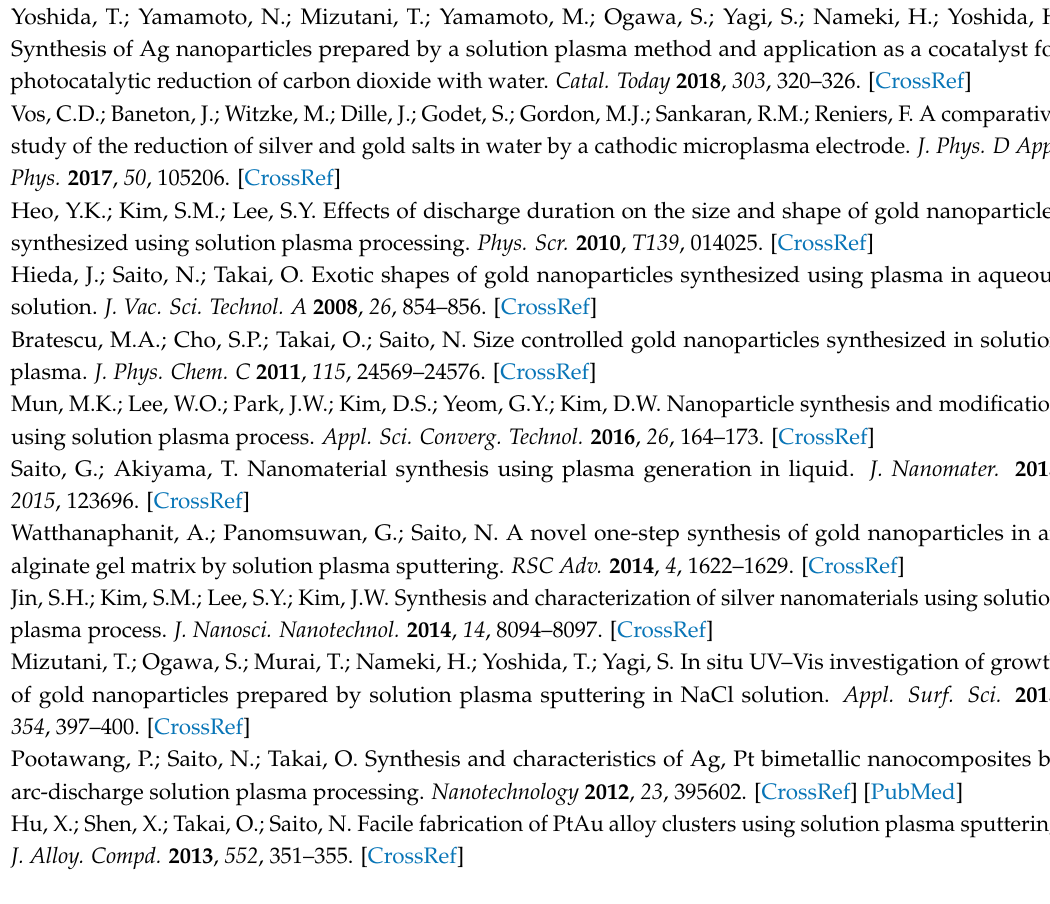
Figure S1: Solution color changes for three cases according to plasma process time, Figure S2: Change in length of powered and grounded Ag electrodes, Figure S3: Shape of Ag electrodes after and before SPP treatment, Video S1: bubble formation of 20 µ s voltage pulse width, Video S2: bubble formation of 40 µ s voltage pulse width, Video S3: bubble formation of 60 µ s voltage pulse